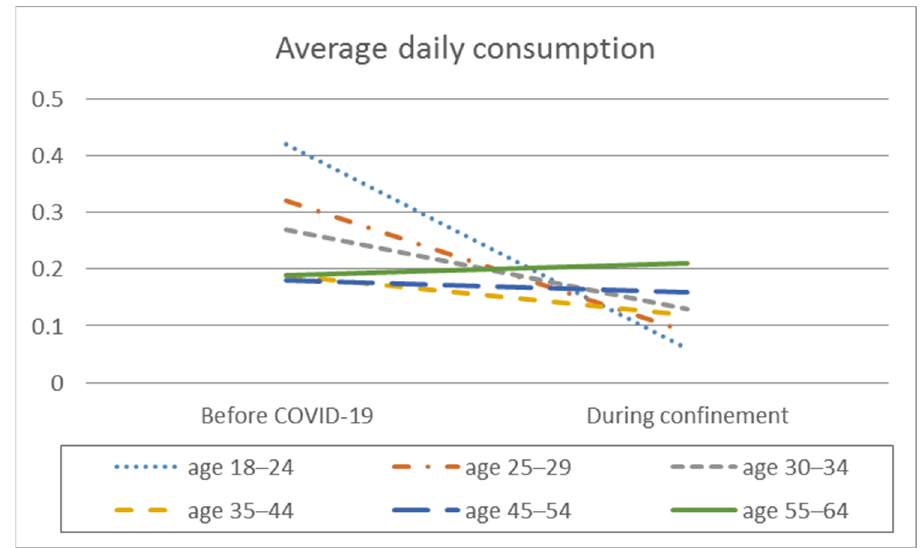
Figure 2. Average daily alcohol consumption by age before the pandemic and during COVID-19 confinement.